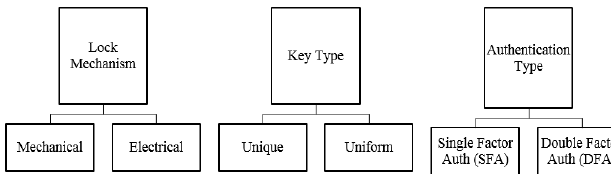
Fig. 1. Dimensions of analysis of the Lock System